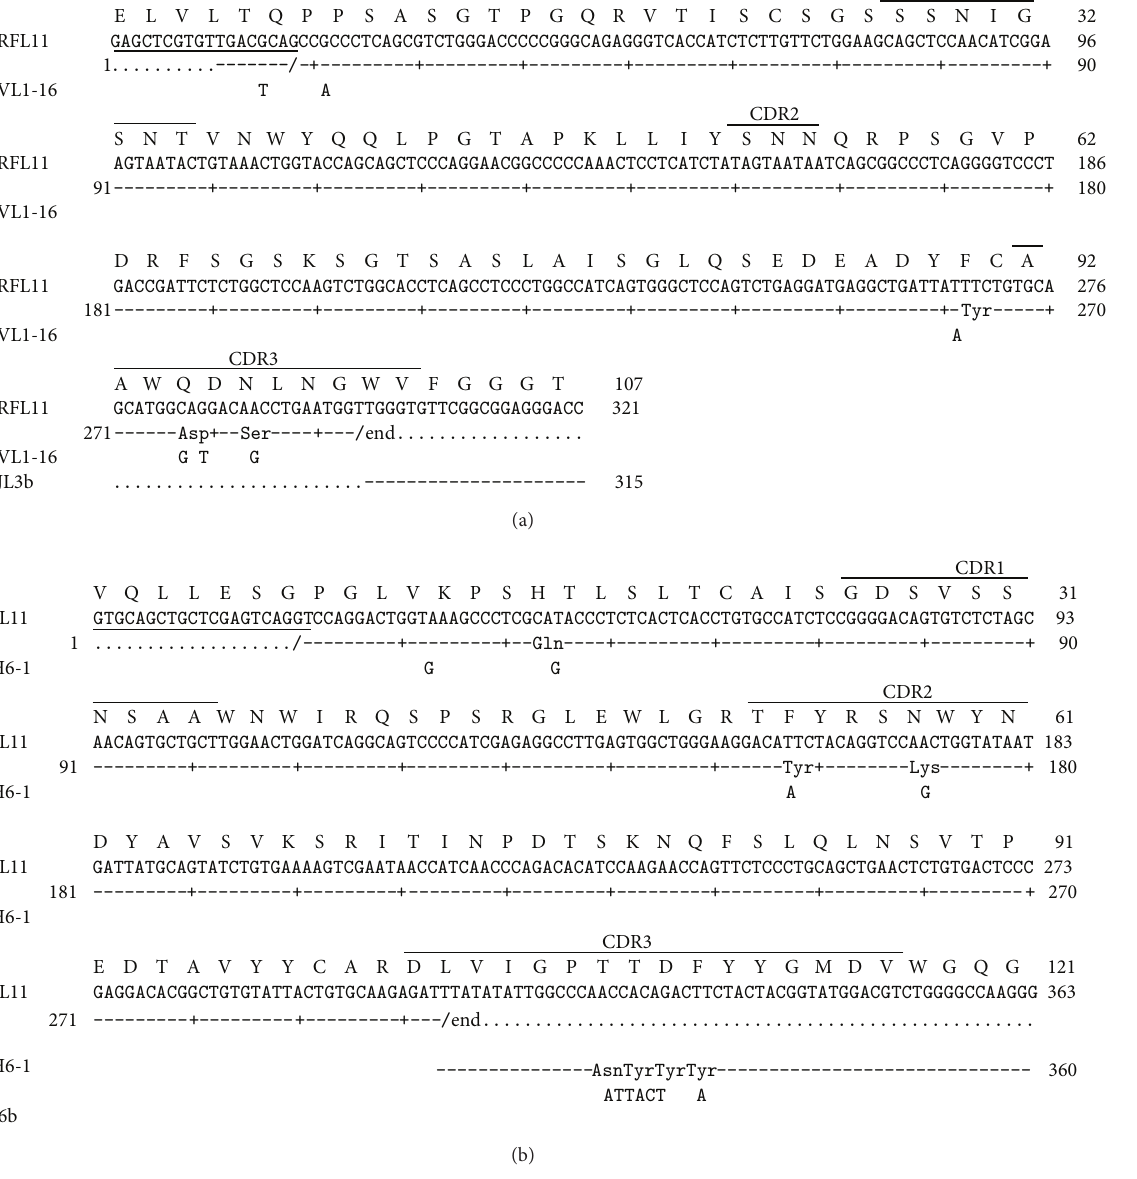
Figure5:Sequenceanalysisofvariableregionsoflightchain(VL)inthepanel(a)andheavychain(VH)inthepanel(b)ofRFL11Fabantibody. The sequences of putative germline counterpart were included for comparison. Sequence gaps were introduced to maximize alignment as indicated by blank spaces. The boundaries of framework region (FR) and complementarity-determining region (CDR) were indicated above each germline gene